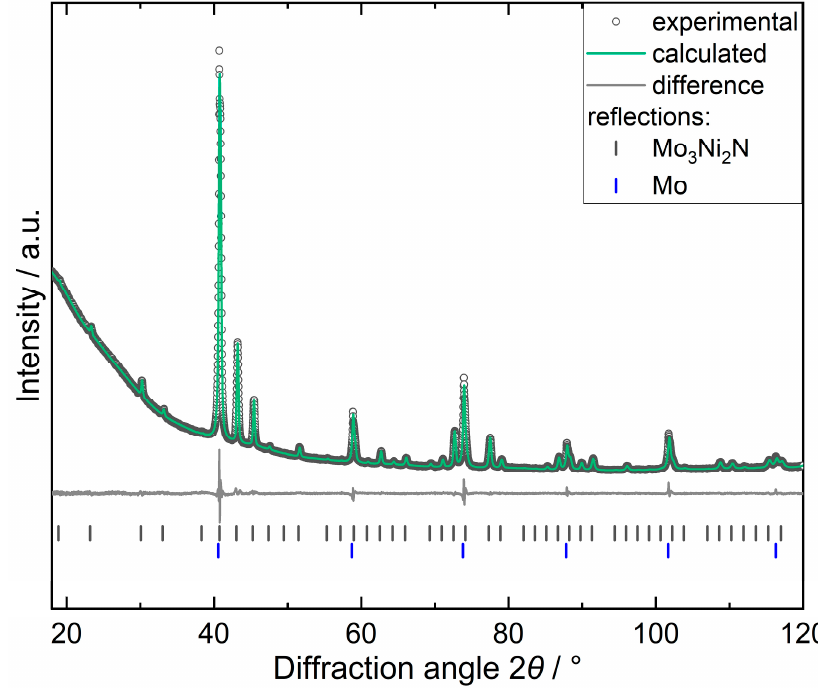
Figure 3. Rietveld refinement of Mo 3 Ni 2 N. Rietveld refinement results in residuals R = 0.0169 and wR = 0.0198 (Table 1), which